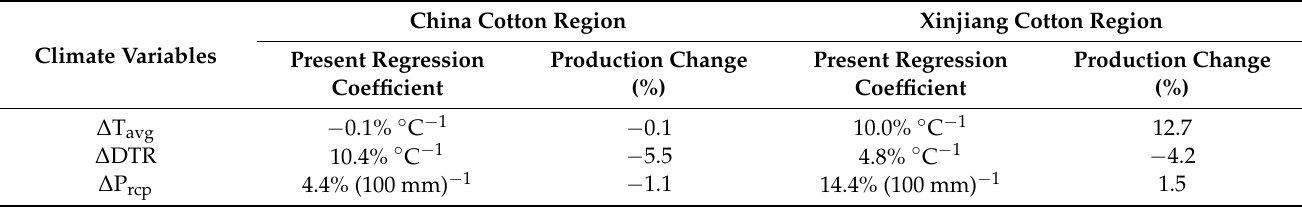
Table 2. Average (%) regression coefficients of average cotton production change and climate variables generated by a past accumulated change in climatic variables in the cotton-producing regions of China from 1980–2018 (Where ∆ T avg average change in temperature, ∆ DTR change in diurnal temperature range and ∆ P rcp average shift in